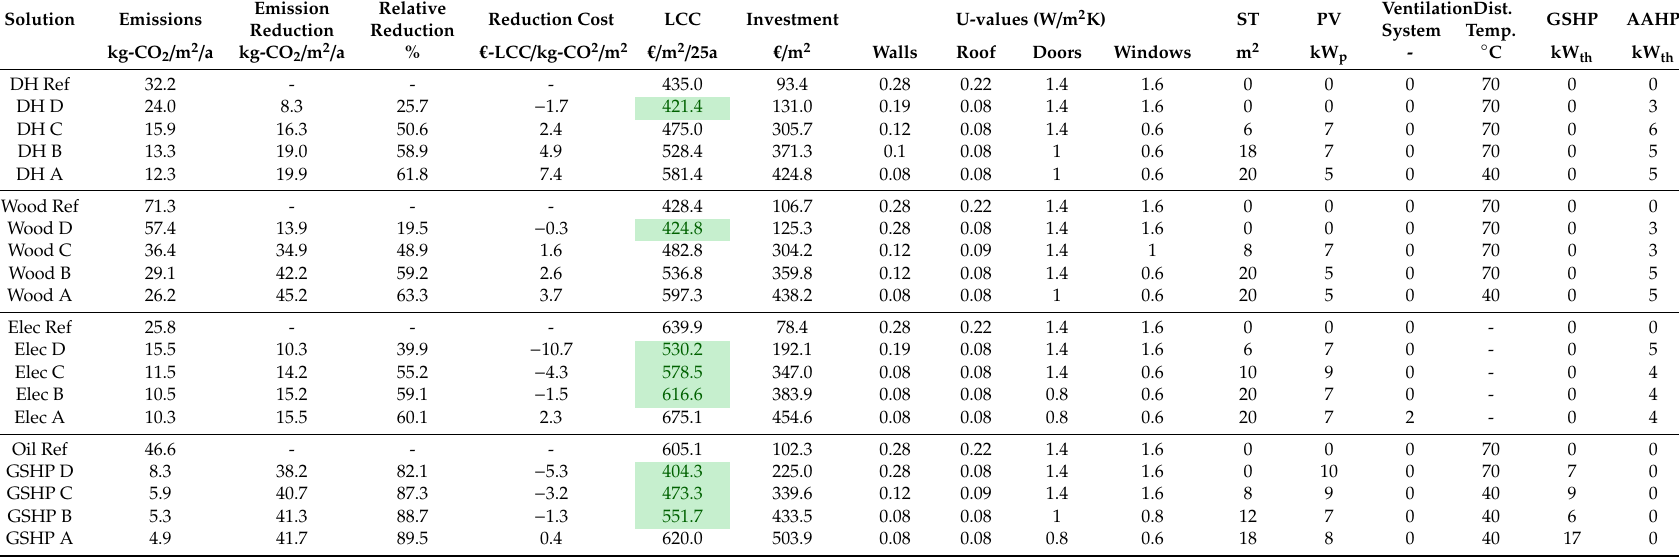
Table 12. Selected optimal cases for SH2 with all heating systems. Cost-e ff ective solutions are marked in green. Cases D to A are optimized solutions from the lowest to the highest LCC. For the ventilation system: 0 is mechanical exhaust ventilation, 1 is mechanical supply and exhaust ventilation with 75% HR e ffi ciency, and 2 is mechanical supply and exhaust ventilation with 75% HR and